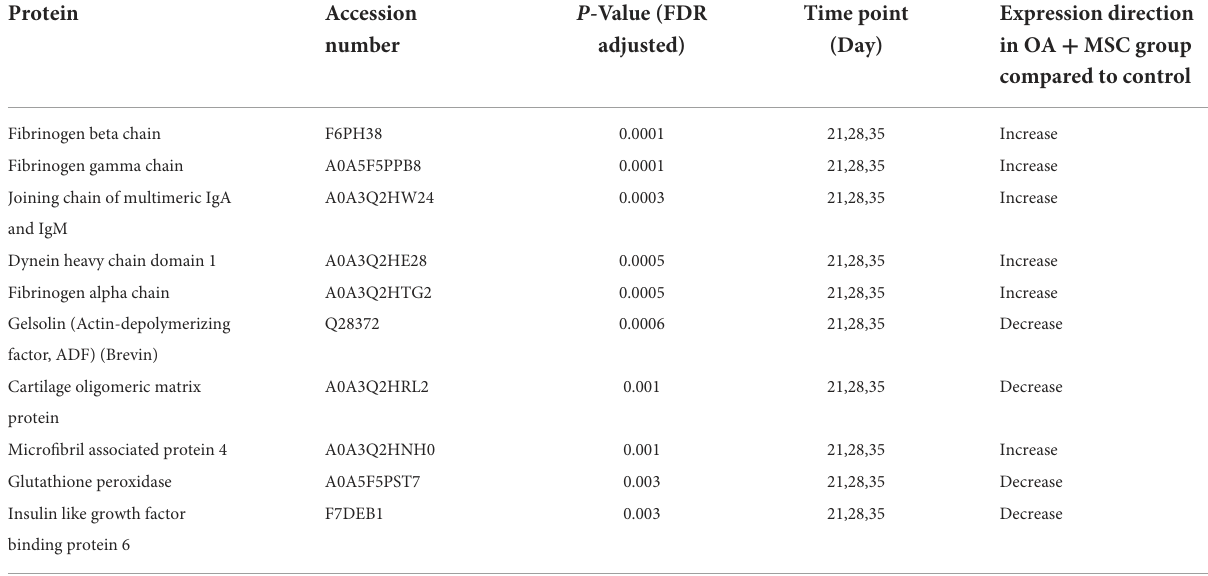
TABLE 2 The top 10 differentially expressed ( p < 0.05) proteins following the application of the linear mixed model, accounting for treatment and time point.